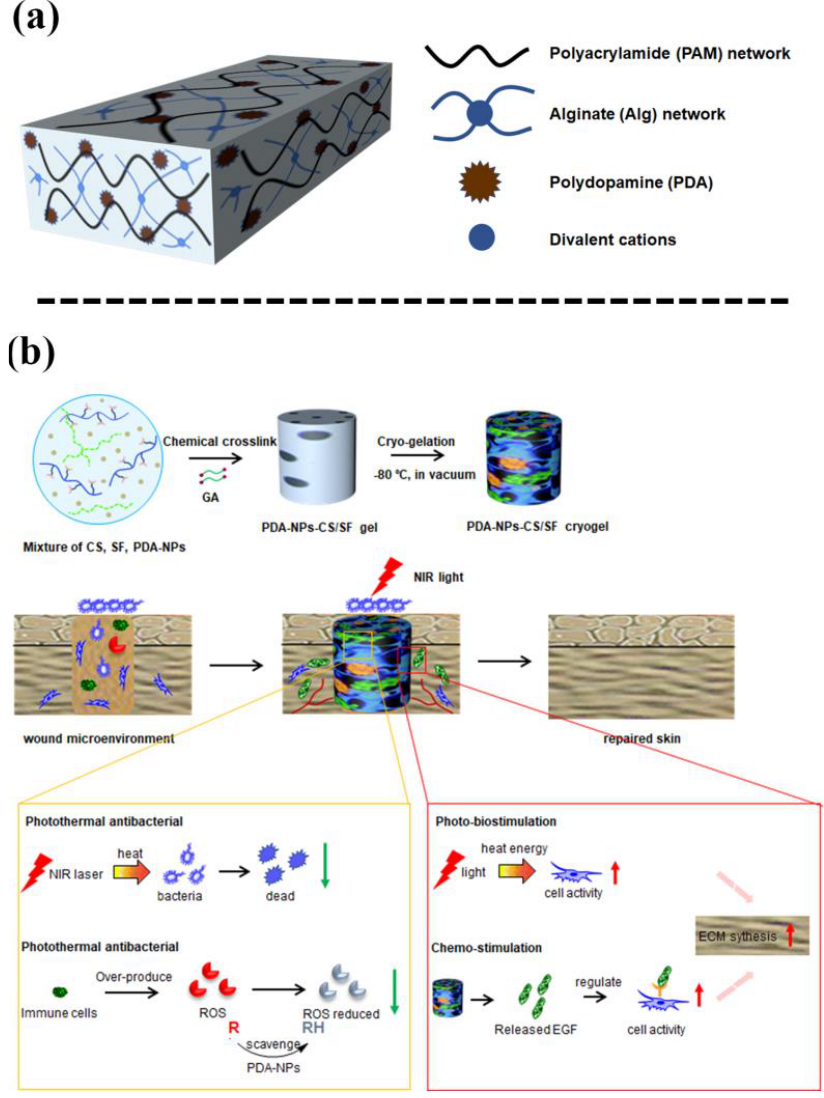
Figure 7. ( a ) Incorporating PDA-NPs into a dual-network of PAM and alginate to form underwater adhesive PAM-Alg-PDA hydrogel [65]. ( b ) Schematics of mussel-inspired PDA-chitosan-silk fibroin cryogel as a photothermal patch for promoting wound regeneration [66].